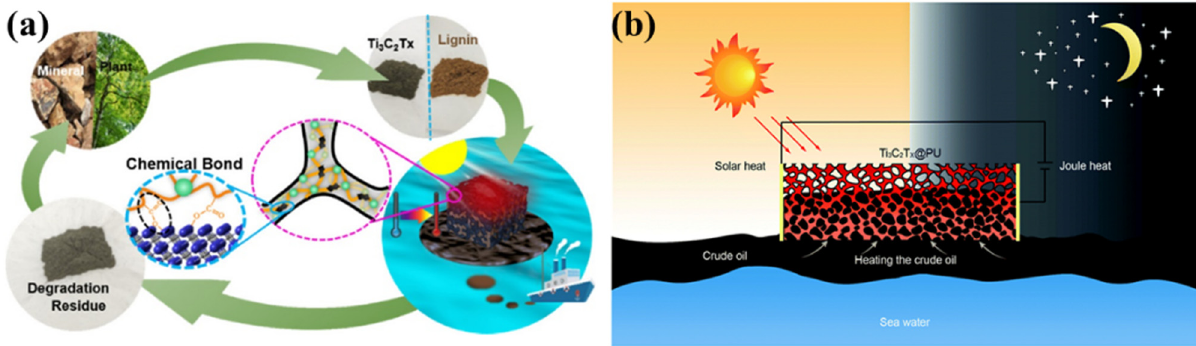
Figure 3: ( a ) Schematic diagram of LPUF photothermal conversion crude oil adsorption and recovery [ 62 ] . ( b ) Schematic illustration of all - weather Ti 3 C 2 T X @PU used for viscous oil cleanup [ 63 ]